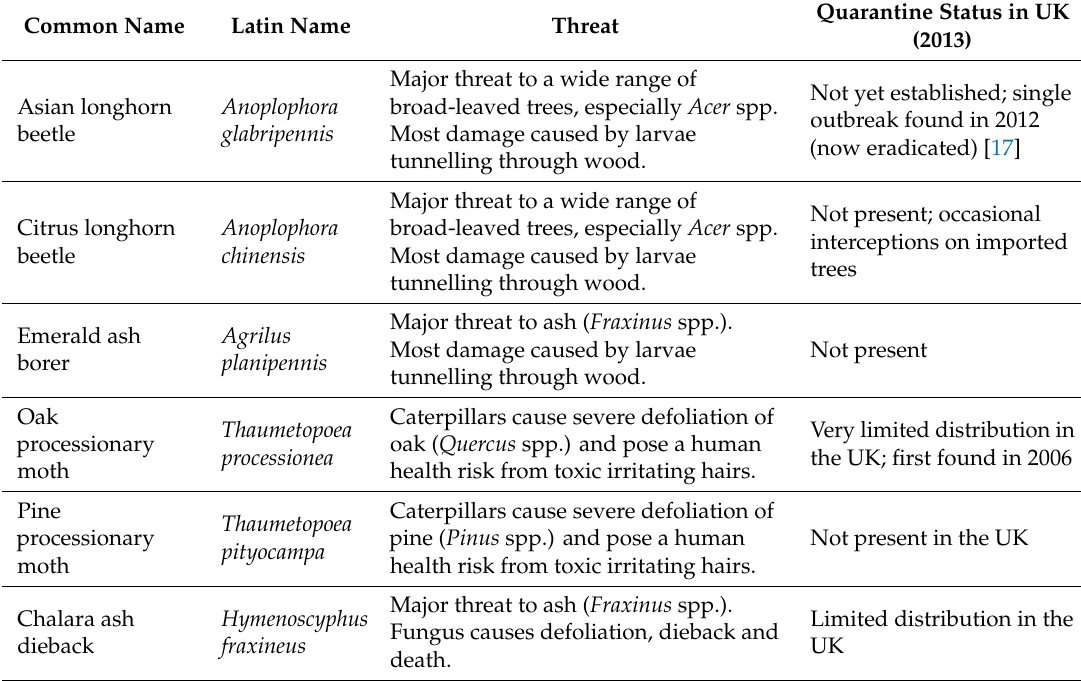
Table 4. Pests included in survey to provide “early warning” information (based on details presented in OPAL’s Tree Pest and Disease Identification Guide).